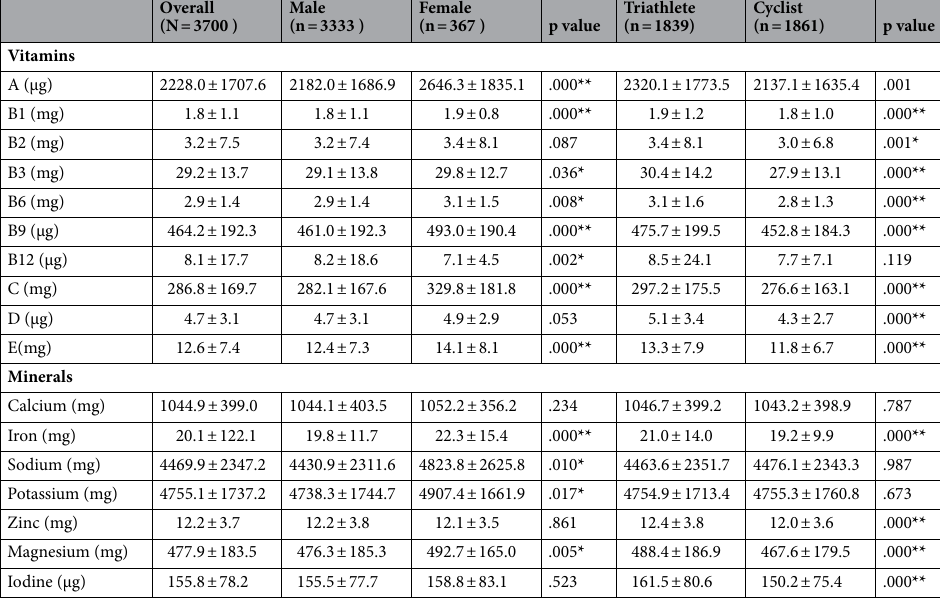
Table 4. Average daily vitamin and mineral intake according to sex and discipline. *p < .05, **p < .001.